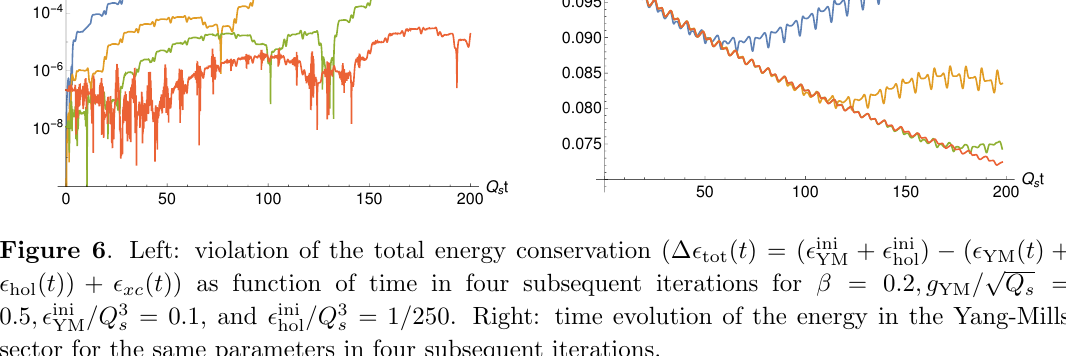
ini + (cid:15) ini ) ( (cid:15) YM ( t ) + tot ( t ) = ( (cid:15) YM hol (cid:0)